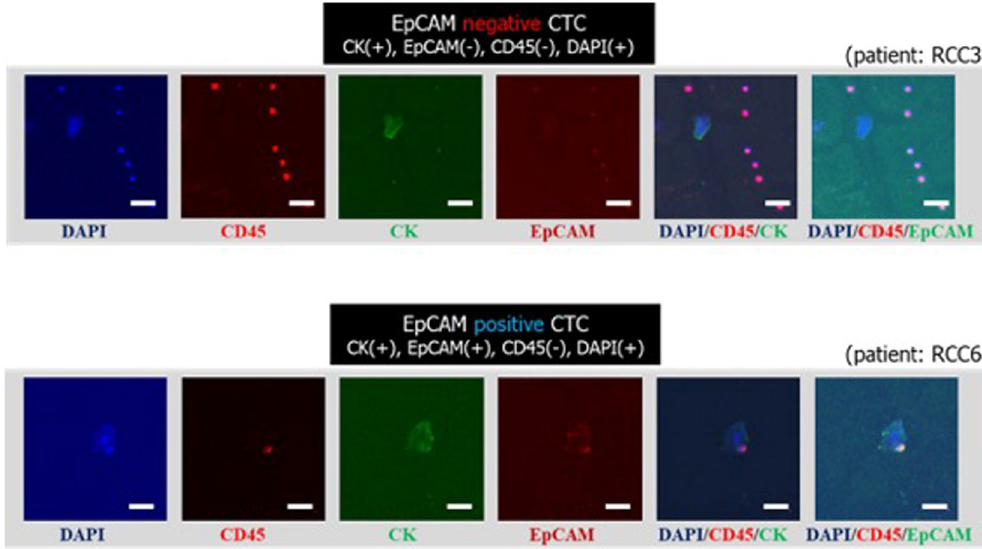
Figure 8. The immunofluorescent images of the isolated circulating tumor cells by the present multi-physical CTC isolation method (Scale bar: 20 μ